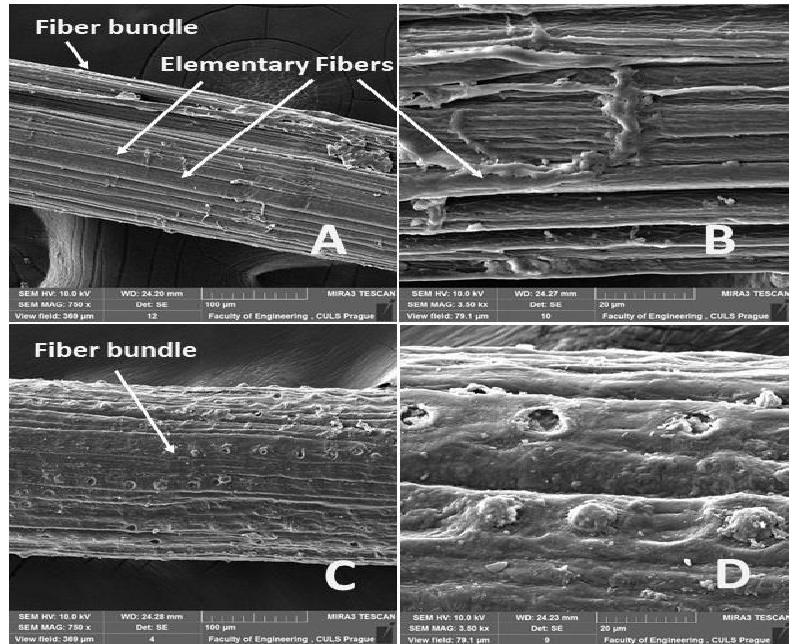
Figure 9. SEM images of the surfaces of abaca and coir fibers with treatment in a 5% solution of NaOH for 12 h: ( A ): abaca fiber bundle (MAG 750 x), ( B ): detailed view of the surface of an abaca fiber (MAG 3.50 kx), ( C ): coir bundle (MAG 750 x), ( D ): detailed view of the surface of a coir fiber (MAG 3.50 kx).